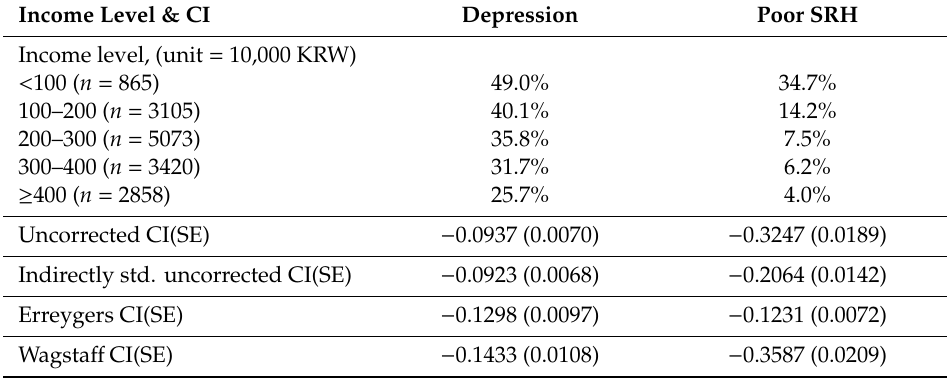
Table 2. Concentration index for self-reported depression and poor SRH.